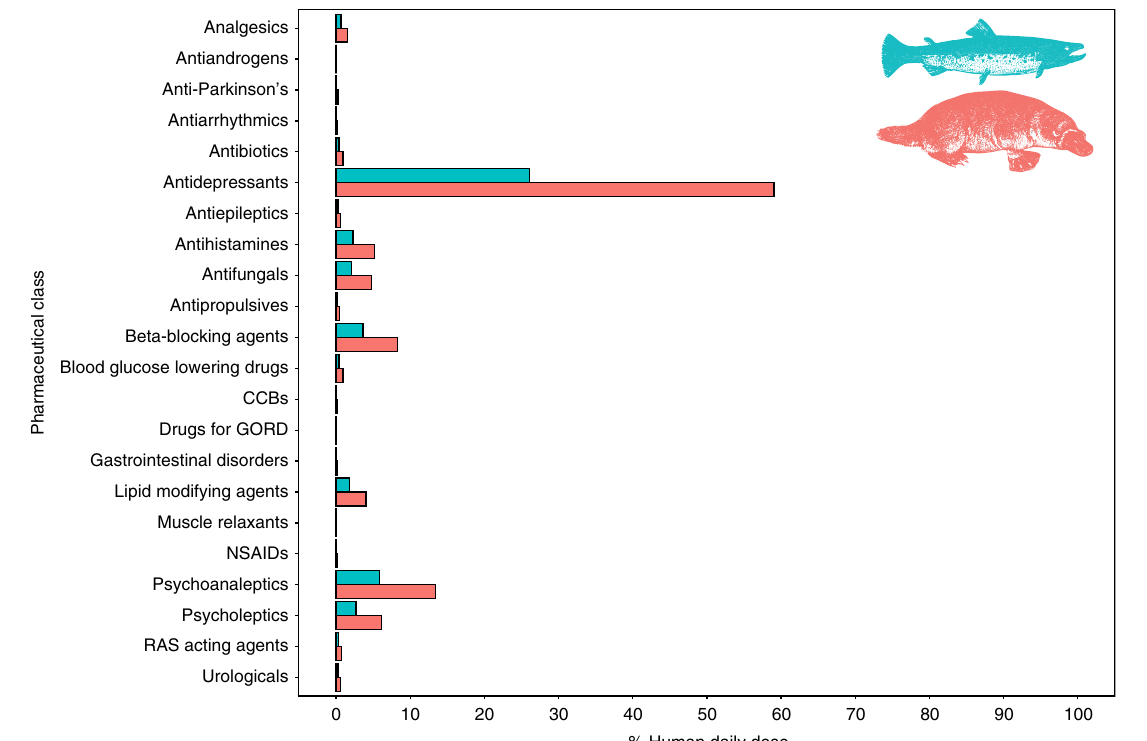
Fig. 4 Estimated dietary intake of pharmaceuticals by two representative invertebrate predators compared to recommended human pharmaceutical doses. Dietary intake rates as a percentage of recommended human pharmaceutical daily doses by therapeutic class for platypus (pink) and brown trout (blue) in Brushy Creek. (CCBs calcium channel blockers, GORD gastroesophageal re fl ux disease, NSAID non-steroidal anti-in fl ammatory drugs, RAS renin angiotensin system). Calculations appear in Methods section (equations 2 – 5). The trout and platypus images in this fi gure were adapted from Harter, Jim. ‘ Animals 1419 copyright-free illustrations of mammals, birds, fi sh, insects, etc. A pictorial archive from Nineteenth century sources ’ Mineola, New